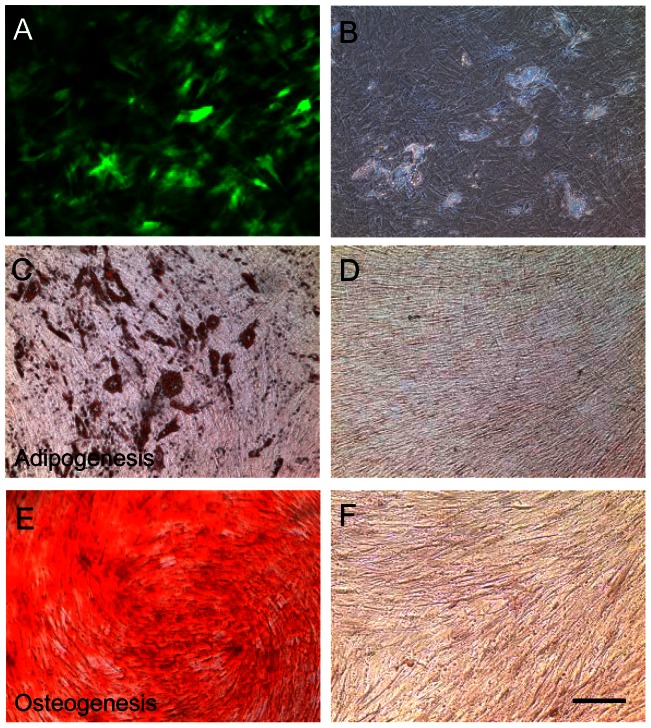
Differentiation of transduced hMSCs.Transduced hMSCs were incubated in either adipogenic or osteogenic differentiation medium in the presence of doxycycline. The cells were fixed with 4% paraformaldehyde and stained with Oil Red O for adipogenic cells (C and D) or Alizarin Red for osteogenic cells (E and F) 3 weeks in vitro. (A) Undifferentiated hMSCs expressed hrGFP. (B) A phase contrast photomicrography of A. (C) Transduced hMSCs differentiated into adipogenic cells versus undifferentiated transduced hMSCs (D). (E) transduced hMSCs differentiated into osteogenic cells versus undifferentiated transduced hMSCs (F). The scale bar  = 50 µm.